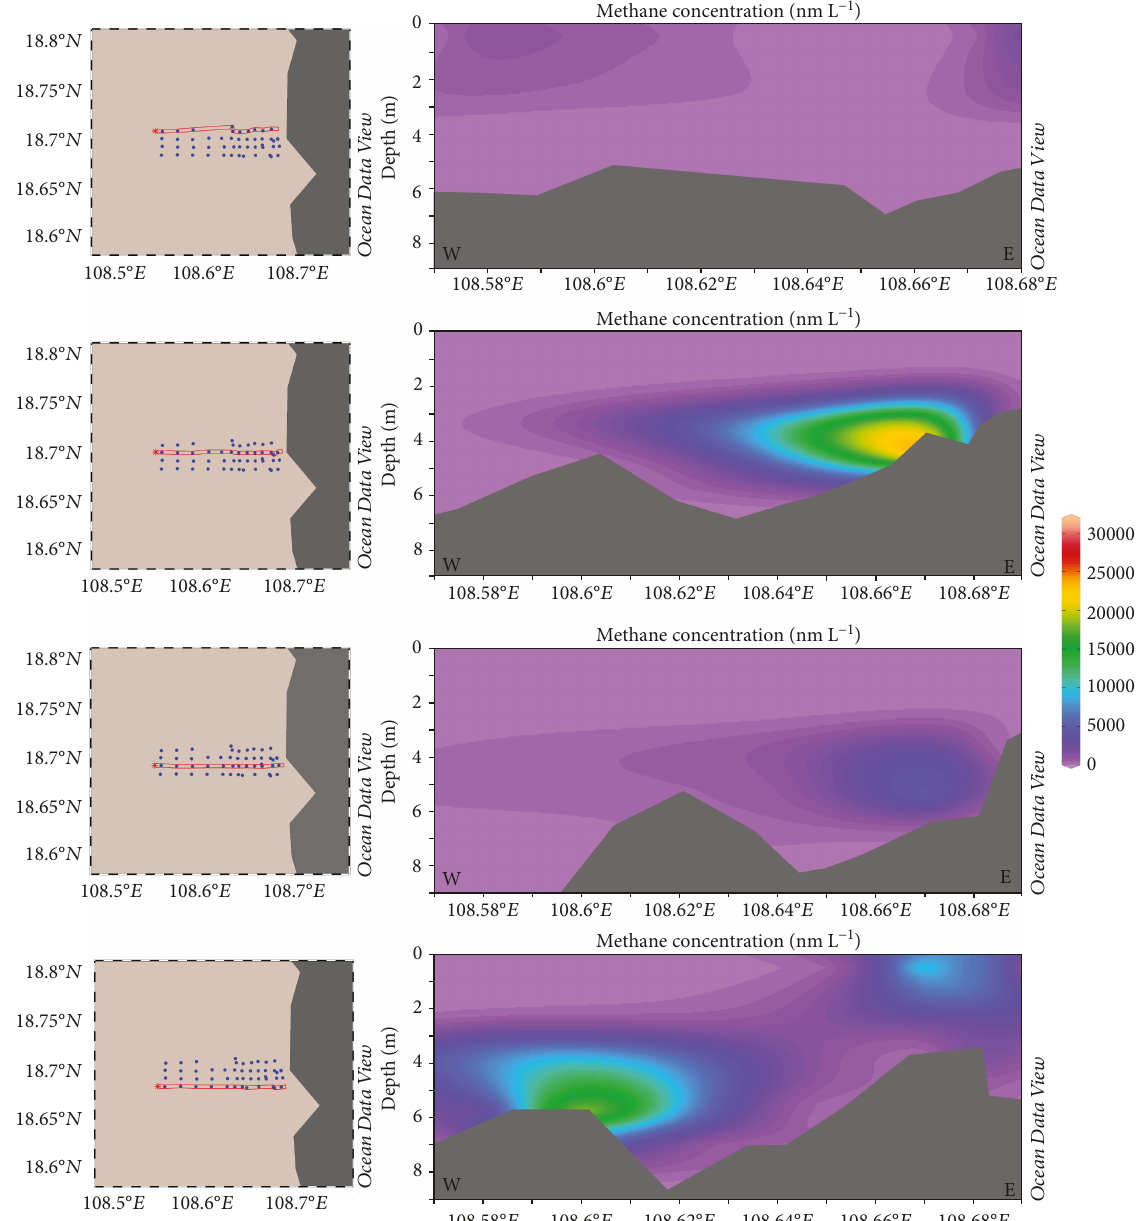
Figure 3: East-west transects of dissolved methane concentrations at the Lingtou Promontory seep area. The red stars are the starting